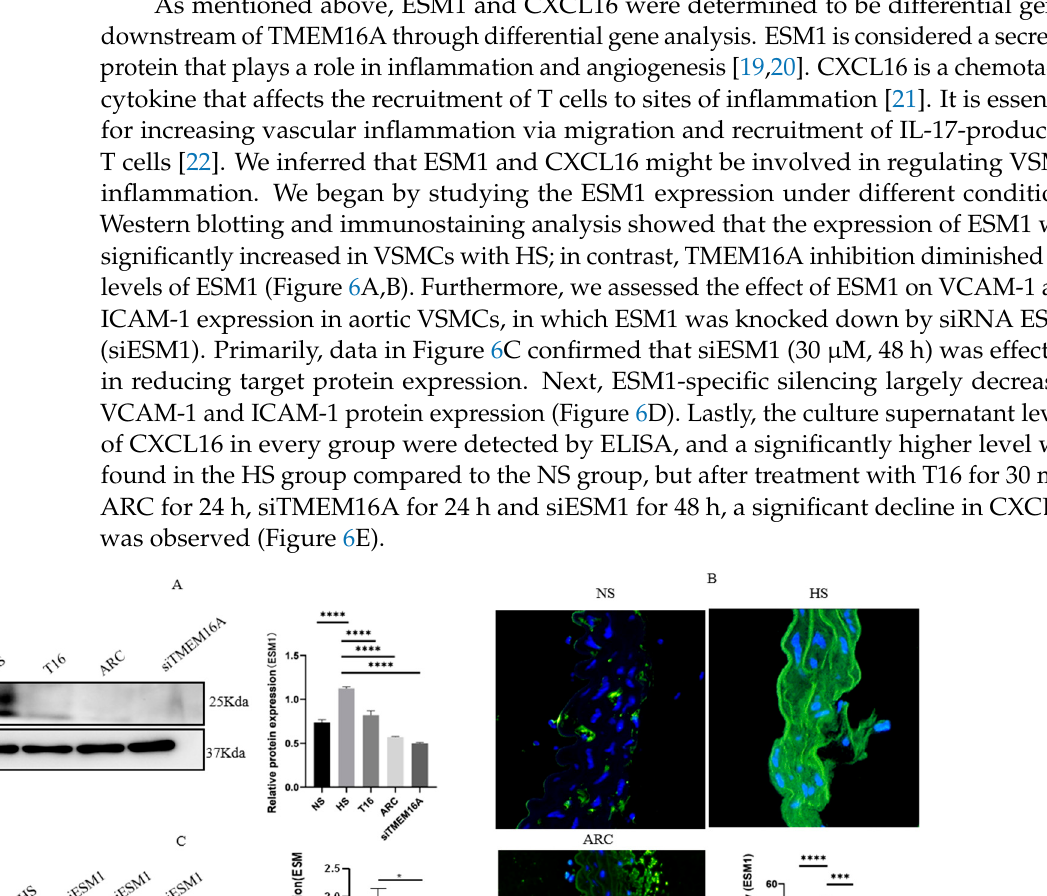
represents nucleus. Mean fluorescence was quantified using one-way ANOVA and p -value